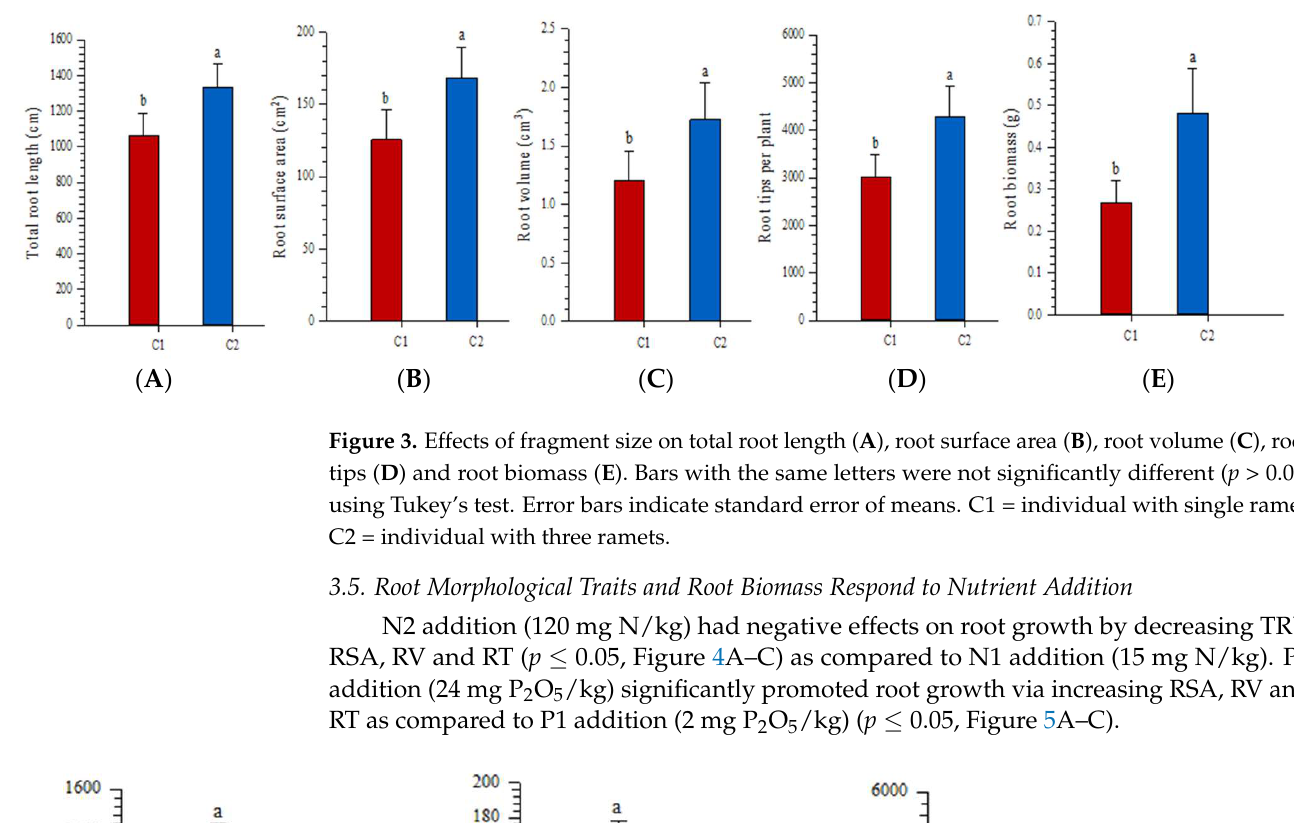
( D ) Figure 2. Effects of water addition on total root length ( A ), root surface area ( B ), root volume ( C ) and root biomass ( D ). Bars with the same letters were not significantly different ( p > 0.05) using Tukey’s test. Error bars indicate standard error of means. W1 = 25% FMC, W2 = 75% FMC. 3.4. Effects of Fragment Size on Root Growth The C2 (individual with three ramets) showed 1.26-fold, 1.34-fold, 1.44-fold, 1.42-fold and 1.84-fold higher TRL, RSA, RV and RT than that of C1 (individual with single ramet)